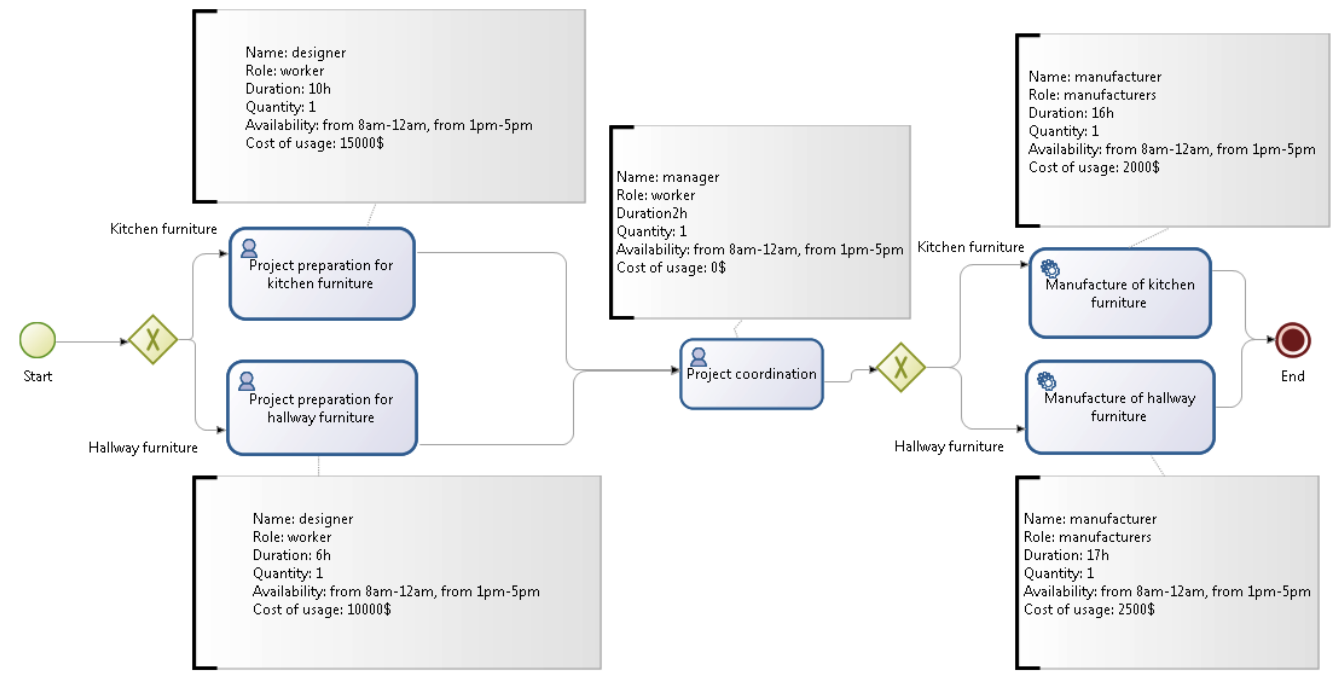
Fig. 3. Business process example with the proposed method (resource elements are